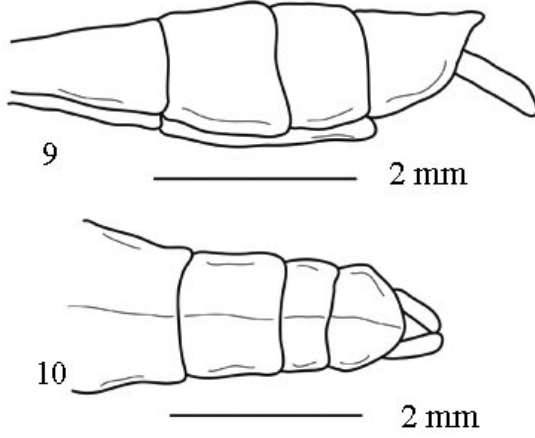
Figs 9–10. Paragongylopus ( Planoparagongylopus ) nabanheensis sub- gen. n. and sp. n. 9. ♀ , apex of abdomen, lateral view; 10. ♀ , apex of abdomen, dorsal